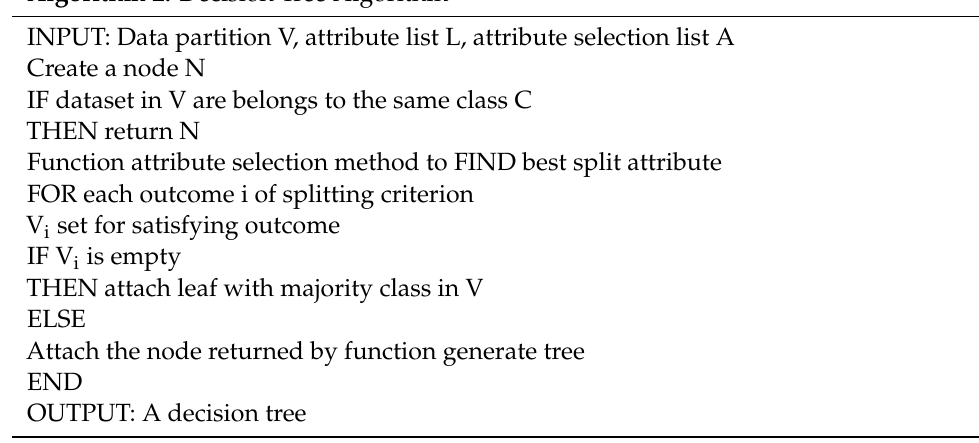
Algorithm 2: Decision Tree Algorithm